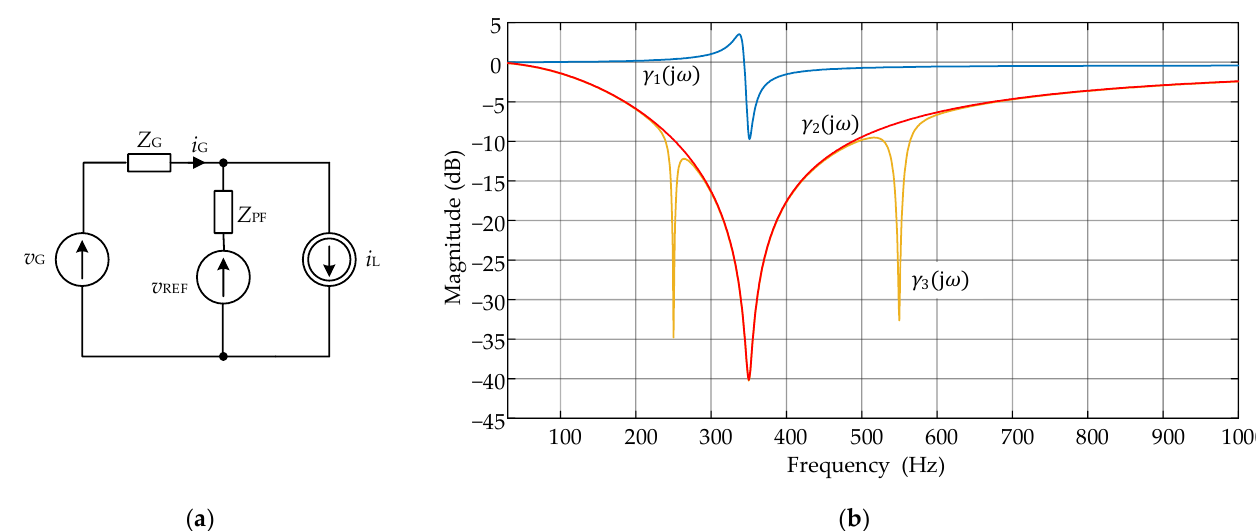
Figure 3. Idea of operation of hybrid active power filter HAPF: ( a ) basic scheme of HAFP; ( b ) harmonic attenuation rate for: passive filter PF tuned for 7th harmonic ( γ 1 ); hybrid active power filter HAPF with control loop CL1, K = 20 ( γ 2 ) and hybrid active power filter HAPF with control loops CL1 and CL2, K = 20, CL2 for 5th and 11th harmonics ( γ 3 ).